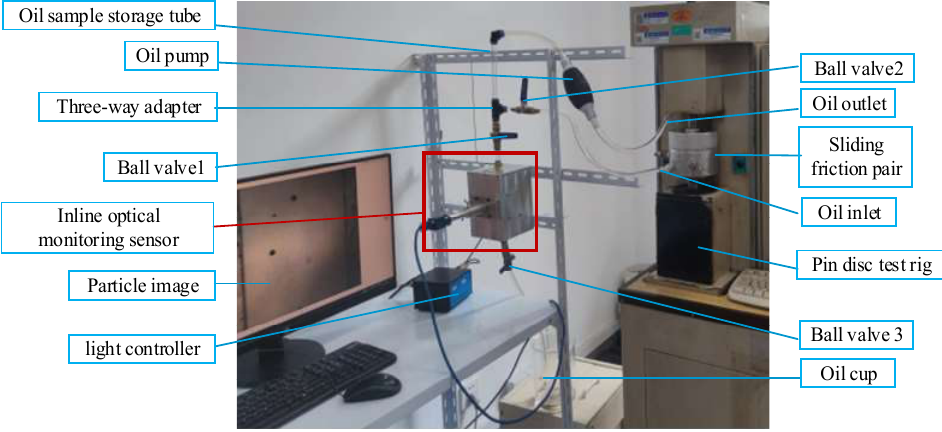
Filter update Figure 14. Schematic diagram of the tracking method based on a correlation filter. (b) For efficient convolution operation, the response function was obtained by first extracting the feature function of the input image using the resolution and combining it with the constantly updated filter. Then a matrix was created, to convolve the feature map based on the feature contribution, thereby reducing the dimensionality of the feature map. The final result was the continuous tracking of the target. 3.4.2. Experimental System The experiments were carried out in the Key Laboratory of Civil Aviation Health Monitoring and Intelligent Maintenance at Nanjing University of Aeronautics and Astro- nautics. The experimental system is shown in Figure 15, which included a MMW-1A pin- disk test rig (particle generator), a self-made full-flow inline optical monitoring sensor, a manual oil pump, an oil storage tube, and other components. Above the oil inlet of the full-flow inline optical sensor, there was a vertical transparent acrylic pipe with a test part under the ball valve 1. The length was 300 mm, which provided a long enough distance